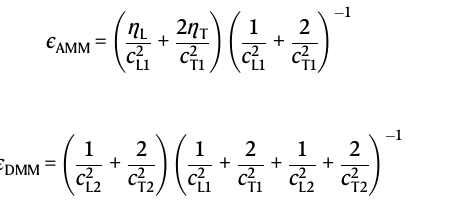
Fig.2|ComparingtheextractedphononemissivitytoAMMandDMM.a I hs T b forrepresentativenanowires.Equation(3)is fi ttothedatausing β and T hs as fi tting parameters with n =4. Legend is shared with b . b Transformation of data in a allowing us to compare wires with different widths and fi tted T hs . Plotted this way, the fi t curves become lines with slope β fit . c , d each histogram entry is colored to indicate substrate. (c) Histogram of β fit = σ ph ϵ AMM (cid:5) (cid:6) β = σ ϵ . e Histogram of n fit that results from re fi tting all I hs T b fit ph DMM allowing β , T hs , and n to